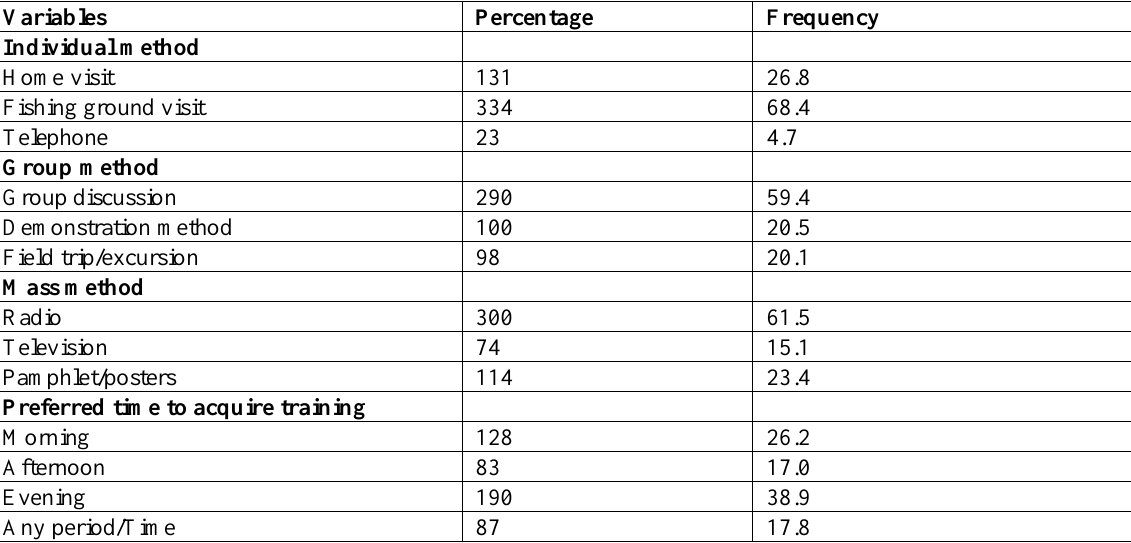
Table1. Distribution of respondents by preferred extension methods and preferred time to